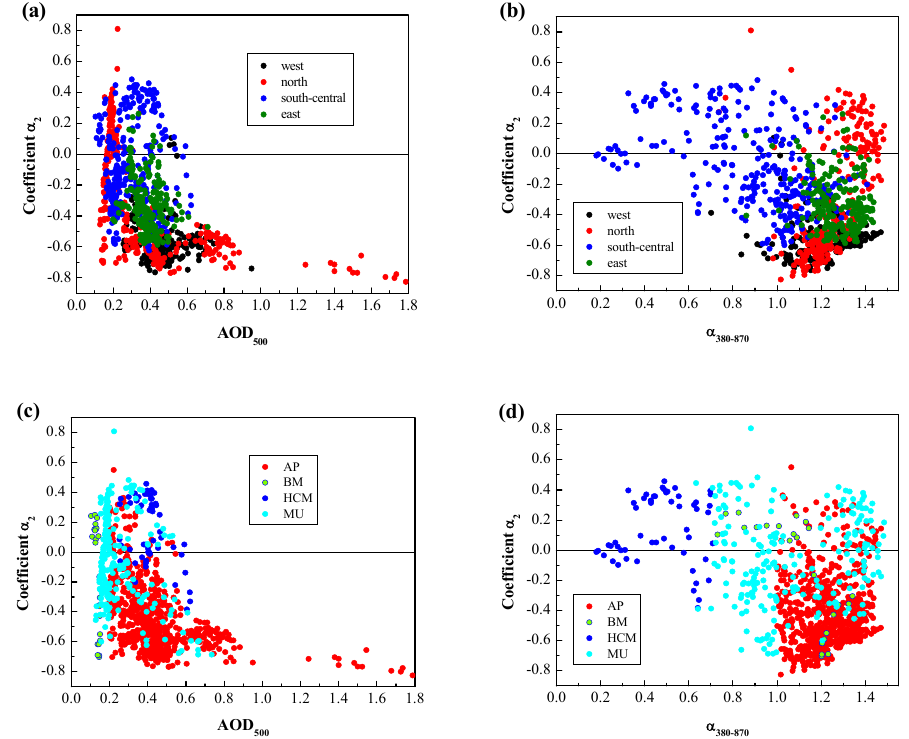
Fig. 8. Correlations between curvature (coefficient a 2 ) and AOD 500 and α 380 − 870 for the four BoB sub-regions (a, b) and for the four aerosol types (c, d) ,